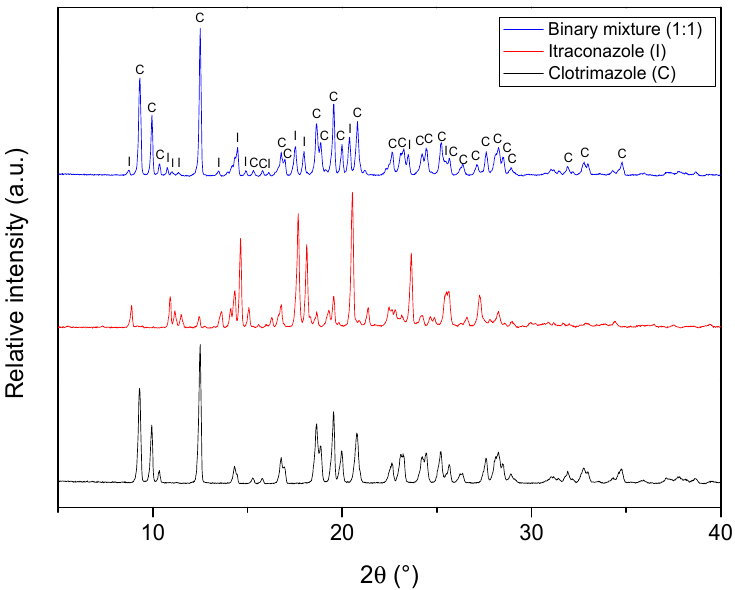
ff ractograms of clotrimazole, itraconazole, and the binary mixture Figure 4. X-ray diffractograms of clotrimazole, itraconazole, and the binary mixture (1:1). Figure 4. X-ray di